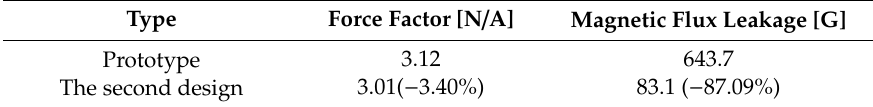
Figure 10. Magnetic flux line: ( a ) prototype; ( b ) second design. Table 5. Comparison of analysis results between the prototype and second design.